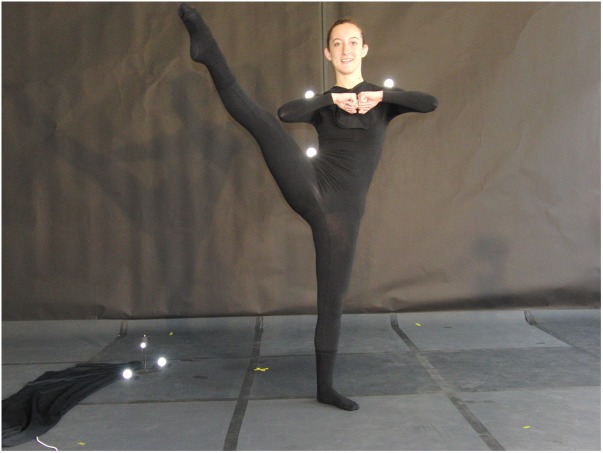
Developpé ending position. Written informed consent was obtained from the model for the publication of this image.